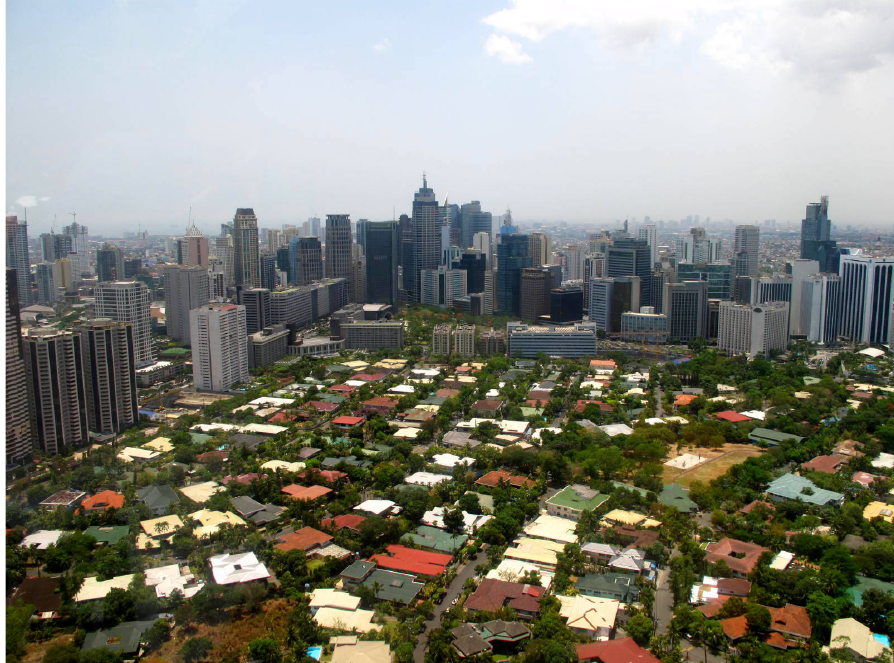
Figure 3. Forbes Park exclusive subdivisions in Makati City (Source: Teoalida, n.d.).